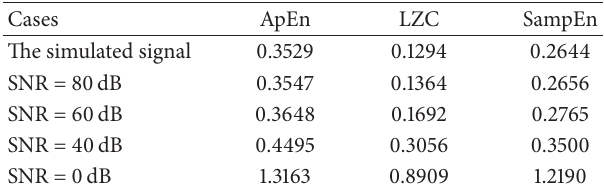
Figure 9: Time computation of both LZC and ApEn for different length of data. Table 2: ApEn, SampEn, and LZC for different SNR of gear